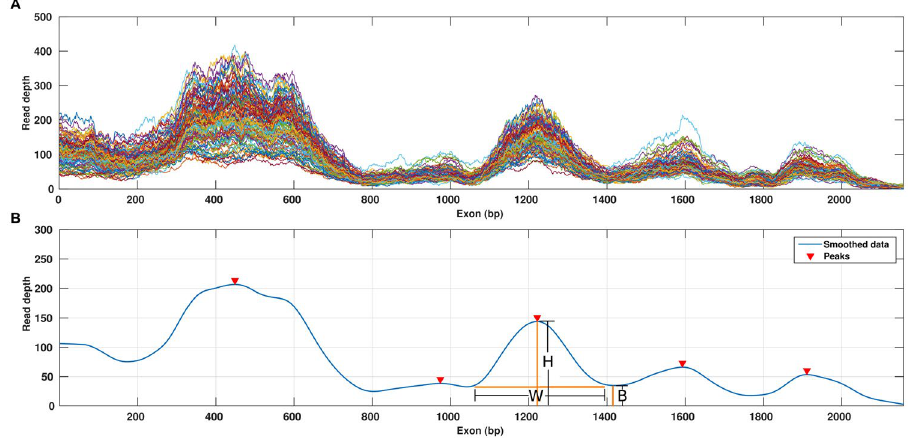
Figure 2. Characterizing the coverage distribution with the Unevenness (U E ) score. ( A ) The coverage distribution from multiple samples is plotted against the exon length. ( B ) The smoothed median coverage plotted against the exon length, obtained by first calculating median coverage for each position and then using LOWESS smoothing. Peaks and troughs were then identified by using a local optimization algorithm. Arrows indicate peaks identified in the curve: B, base, W, width and H, height of the peak, L R , length of the region analyzed.